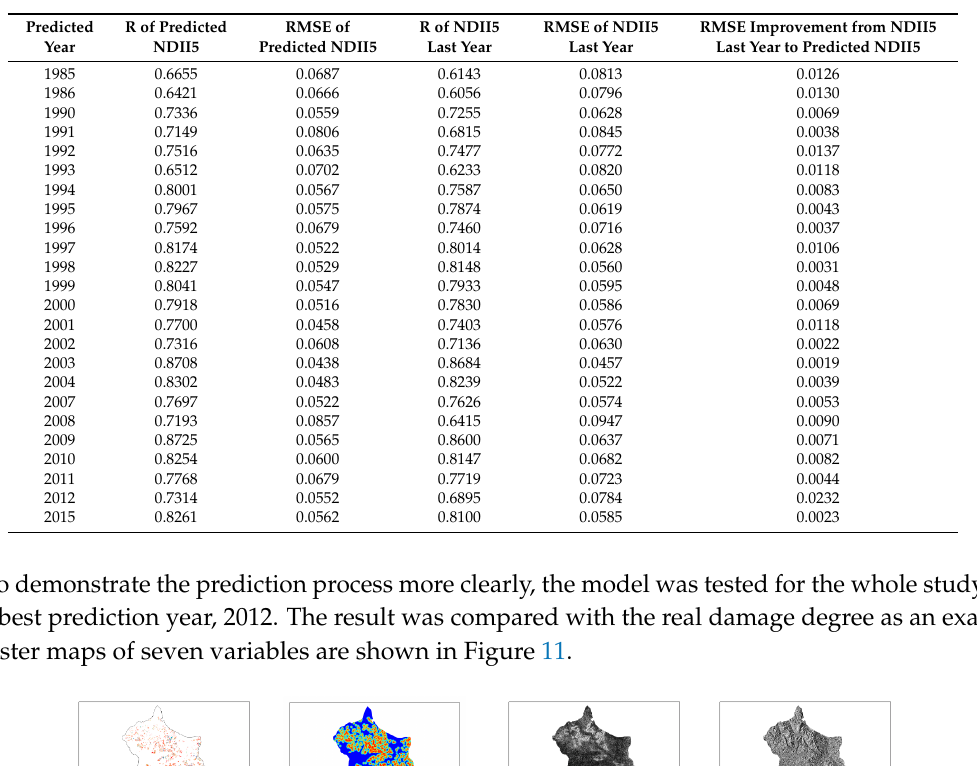
Table 5. The correlation coefficient (R) and error comparison between the predicted NDII5 and the last year NDII5 with the real NDII5.